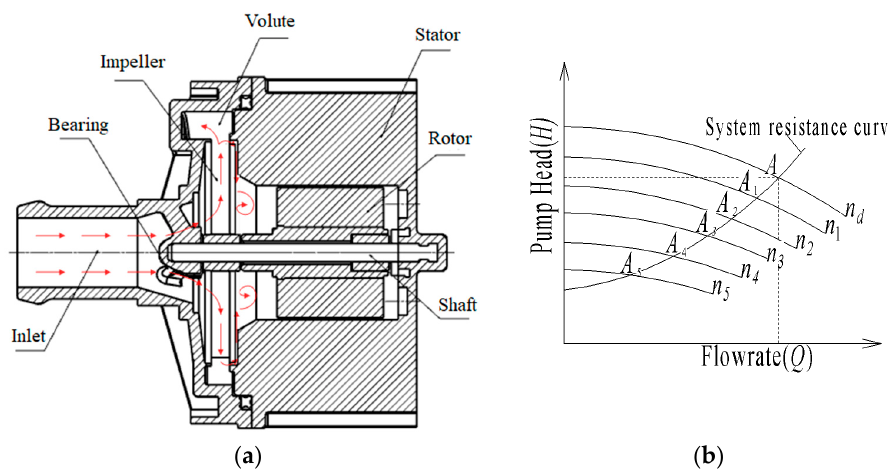
Figure 2. Automobile electronic pump model: ( a ) Structure diagram; ( b ) Performance characteristic curves.